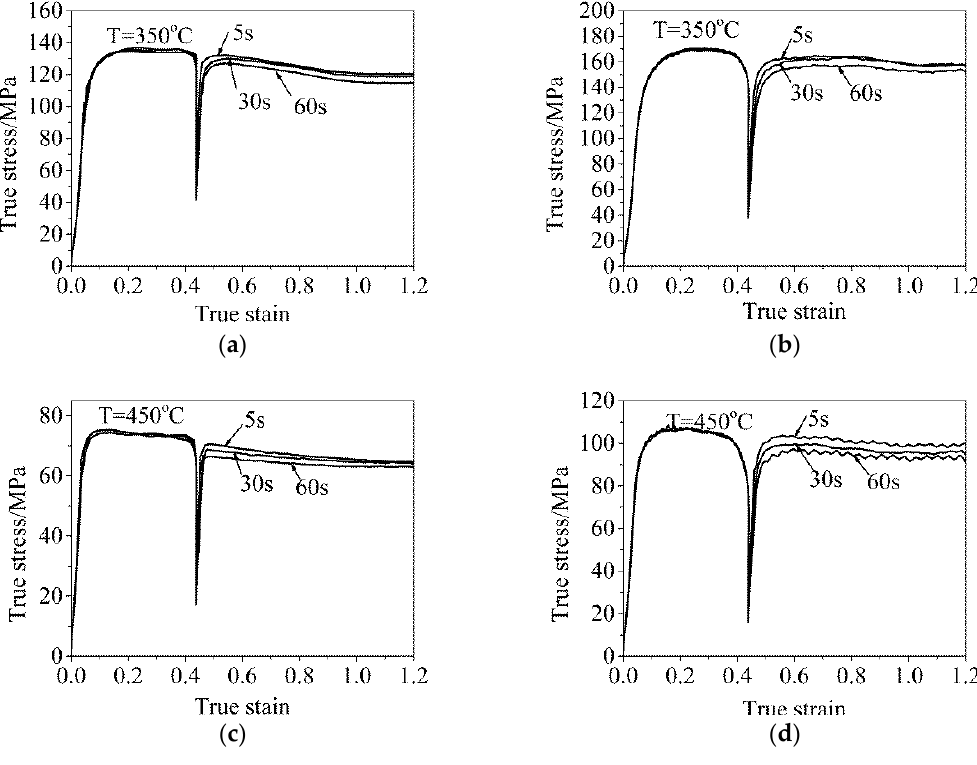
Figure 3. Flow curves resulting from different deformation parameters: ( a ) 350 C  , 0.1 s − 1 ; ( b ) 350 C  , 1.0 s − 1 ; ( c ) 450 C  , 0.1 s − 1 ; ( d ) 450 C  , 1.0 s − 1